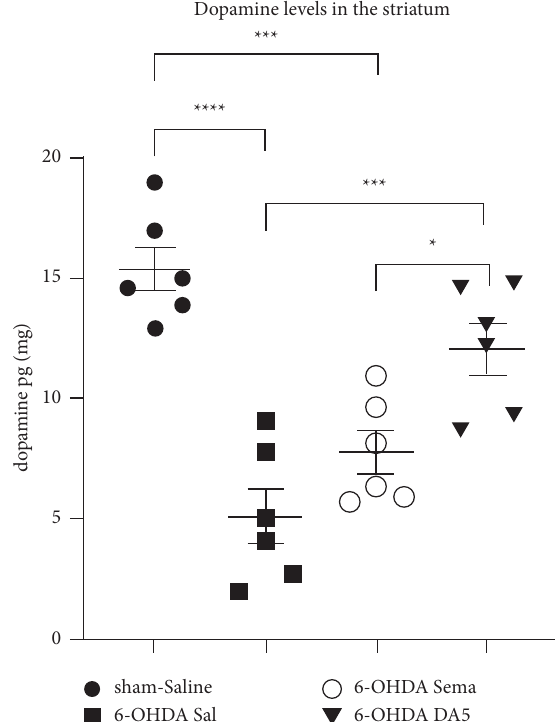
Figure 3: Efects of both drugs on 6-OHDA-induced reduction in striatal dopamine content. Te means ± SEM of six rats per group is shown. A one-way ANOVA followed by the Tukey multiple comparisons test; ∗ � p < 0 . 05; ∗∗∗ � p < 0 . 005; ∗∗∗∗ � p < 0 .